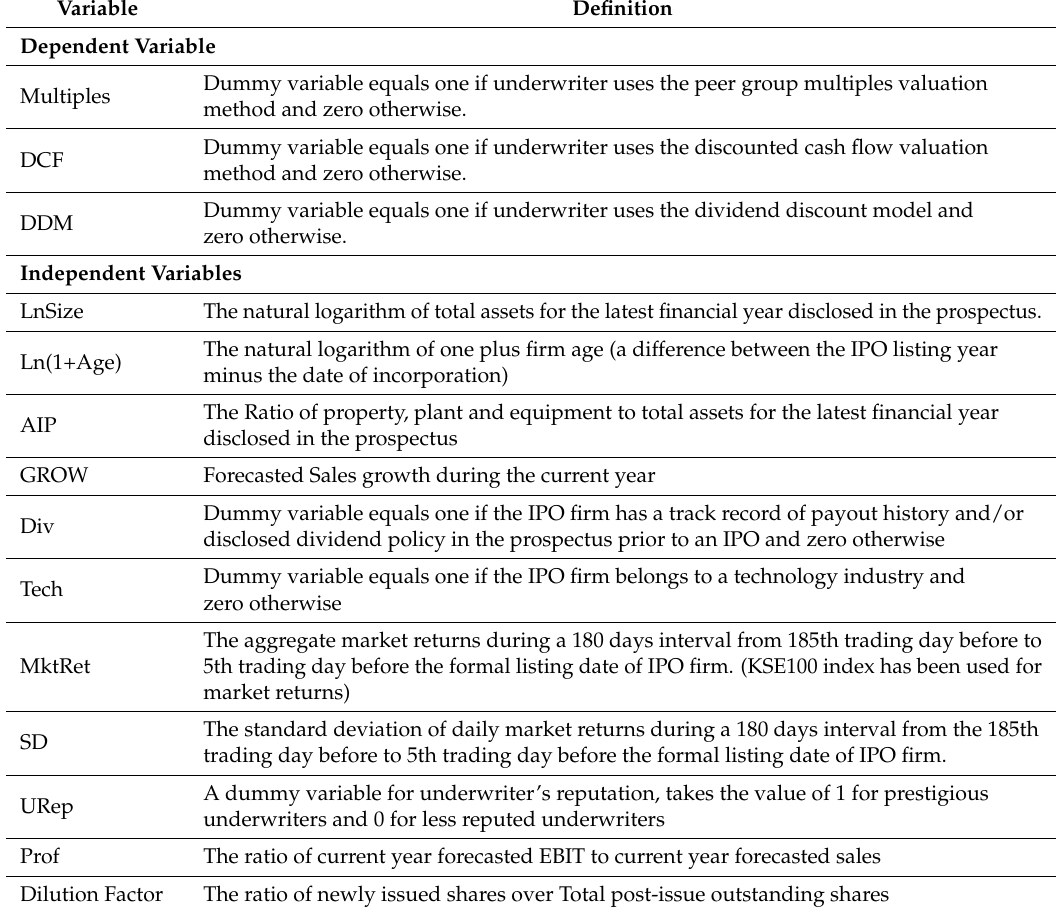
Table 2. Operational definitions of variables used in the binary